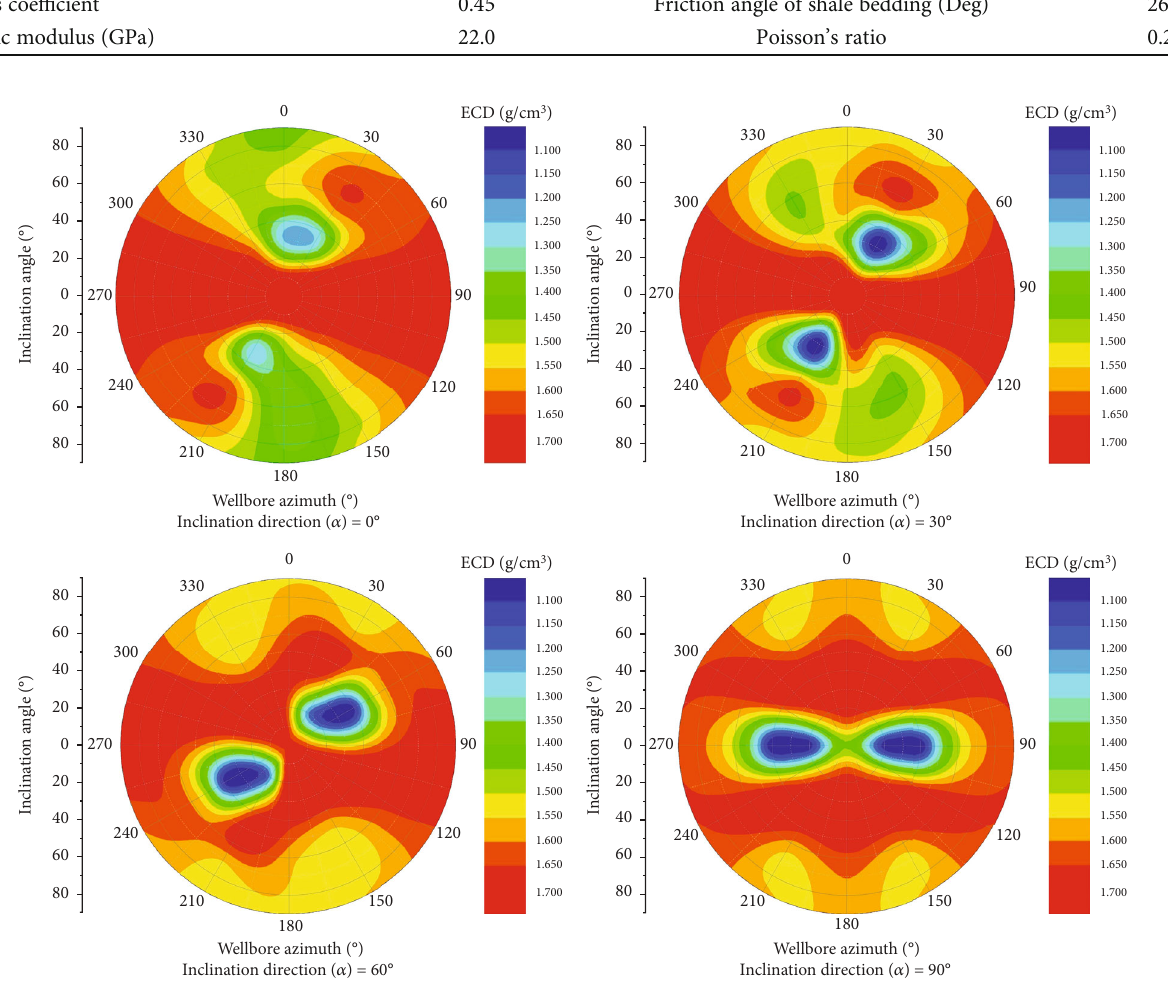
Figure 5: The inclination angle of bedding plane is 30 °